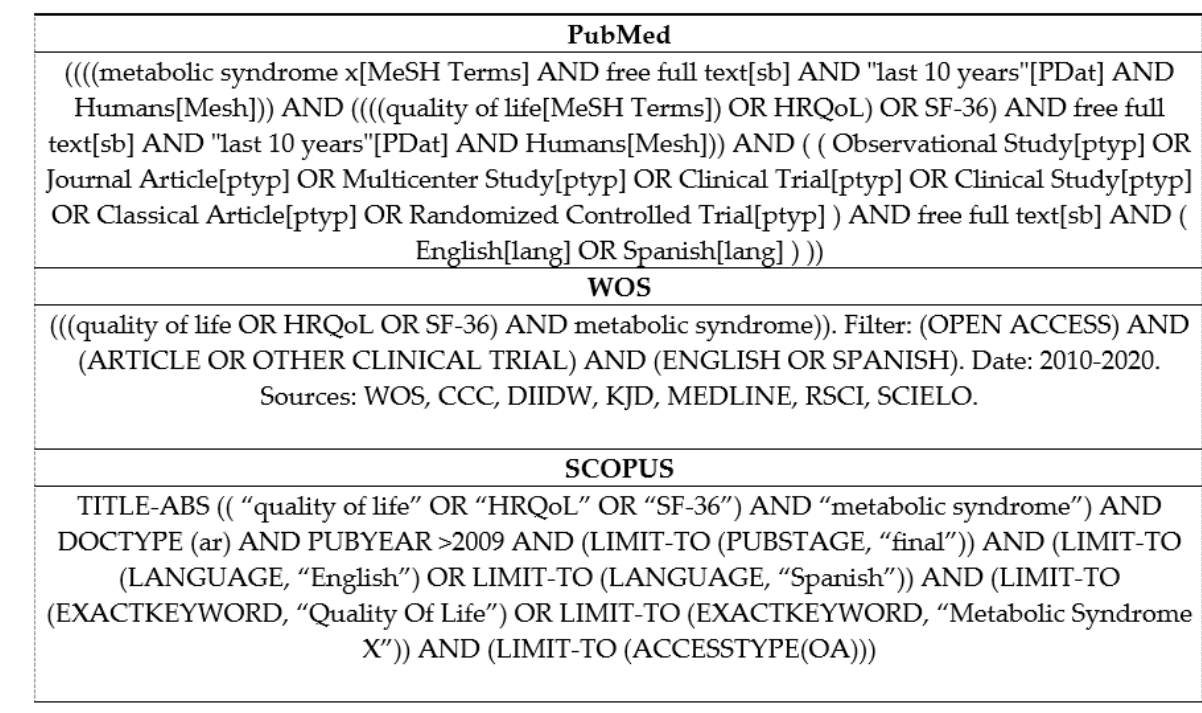
Figure 1. Search